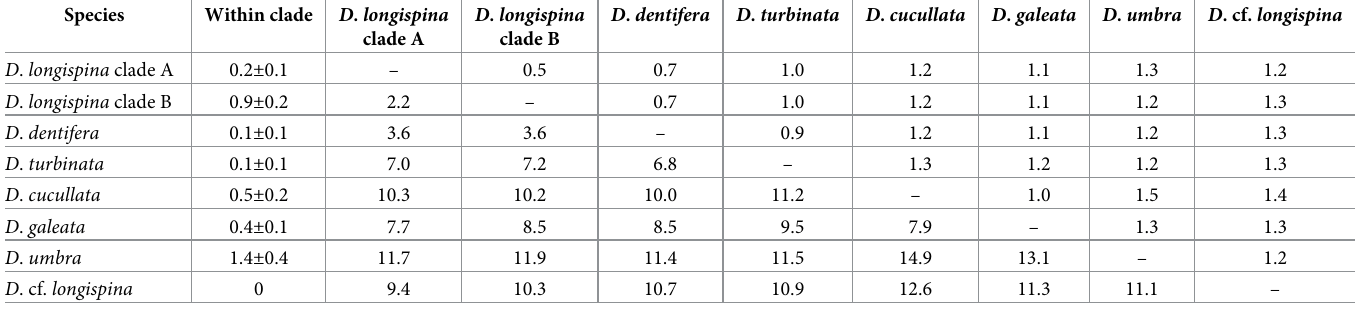
Table 4. Estimate of the evolutionary divergence (uncorrected p -distances, %) over the original 12S sequences pair within and between studied species and clades of the D . longispina complex. Standard error estimates are shown above the diagonal. Species Within clade D . longispina clade